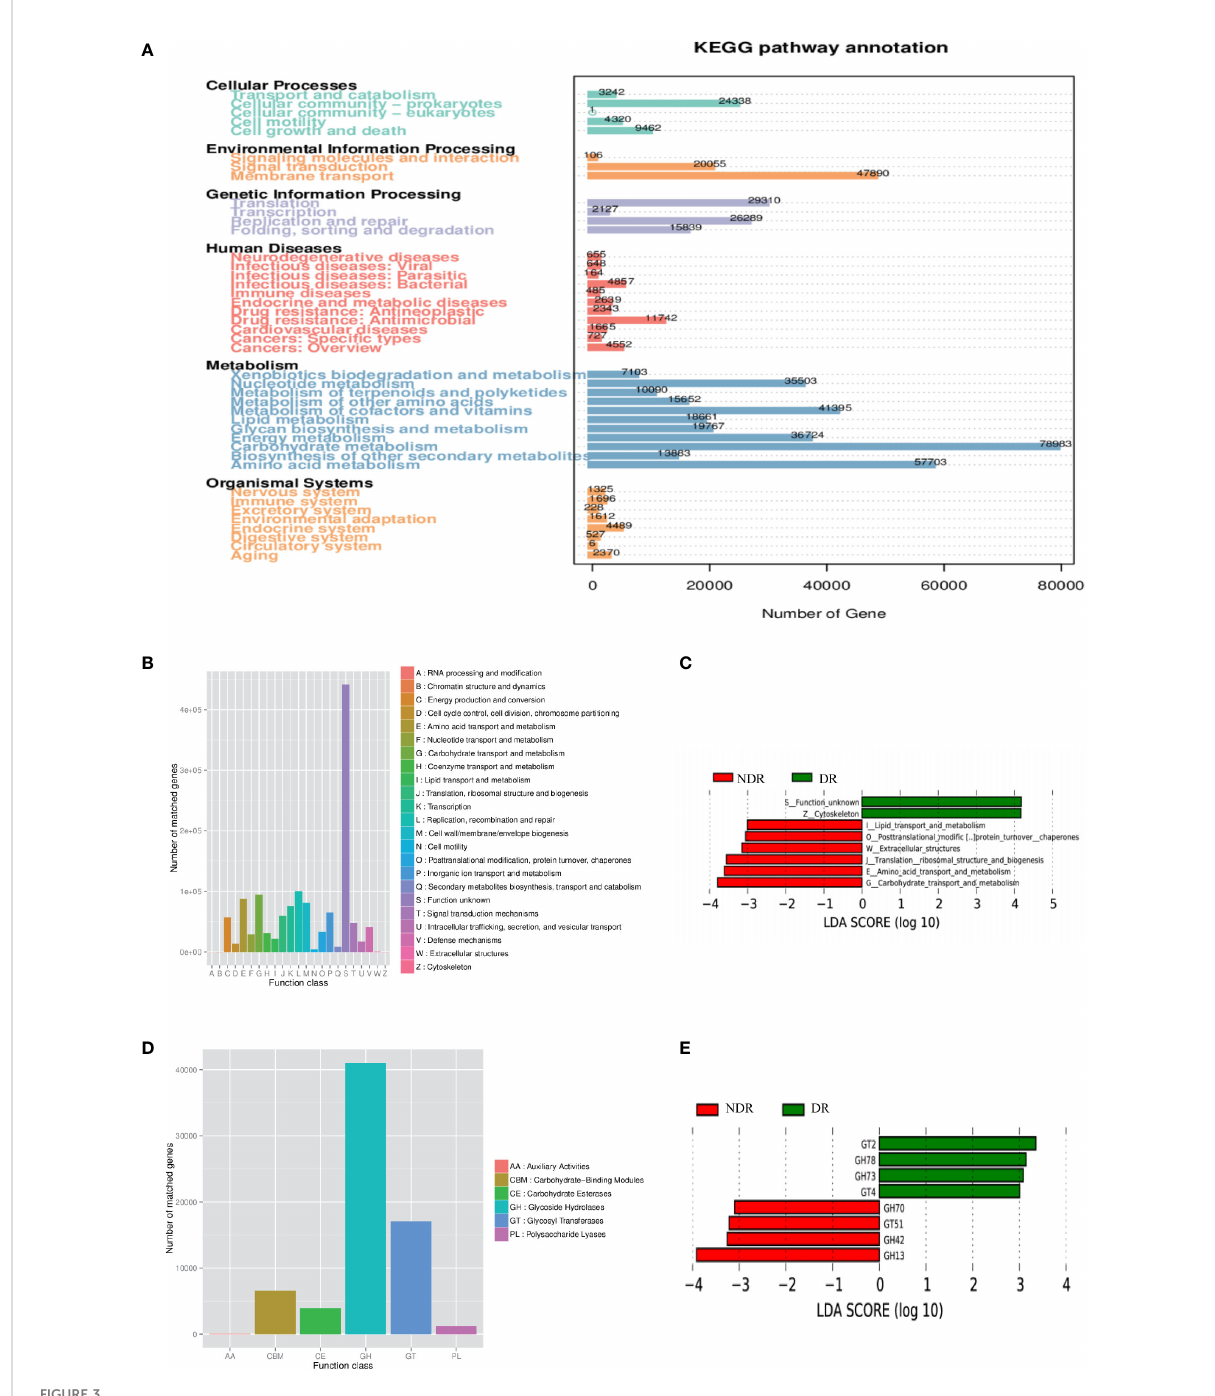
FIGURE 3 Characterization of the gut microbiome from function annotation. (A) The unigene number statistics of the Kyoto Encyclopedia of Genes and Genomes. (B) The unigene number statistics of eggNOG. (C) The LEfSe analysis of the functional differences between the groups of eggNOG. (D) The unigenes number statistics of CAZy. (E) The LEfSe analysis of functional differences between the groups of